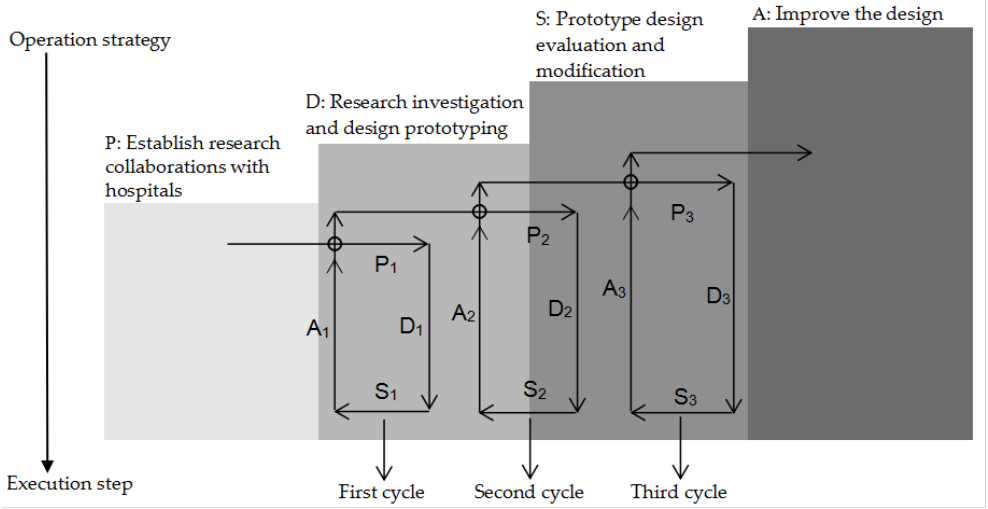
Figure 1. Participatory action research (PAR) steps and framework diagram.